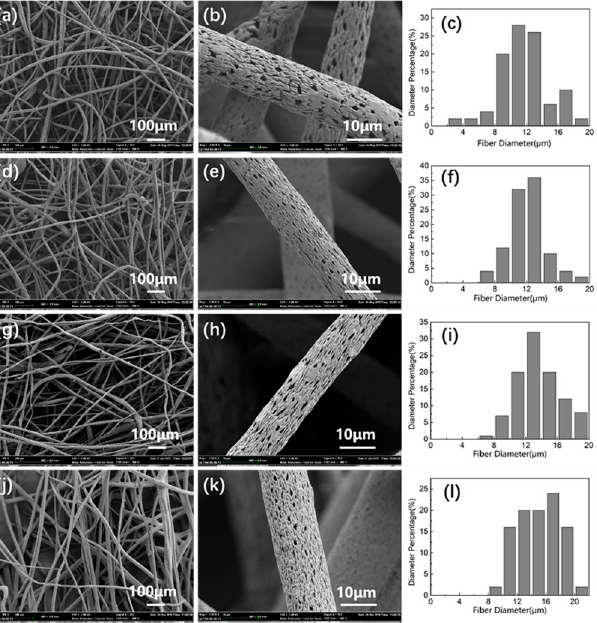
Figure 1. SEM Diagram and Diameter Distribution of Porous Composite Fibers with Different Mass Fractions of MMT: ( a – c ) the mass fraction of MMT is 0%; ( d – f ) MMT mass fraction is 1%; ( g – i ) the mass fraction of MMT is 2%; ( j – l ) MMT mass fraction is 3%.